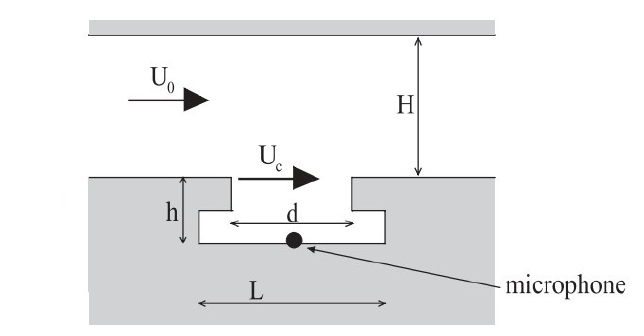
Figure 4. Diagram of Lafon’ experiment.